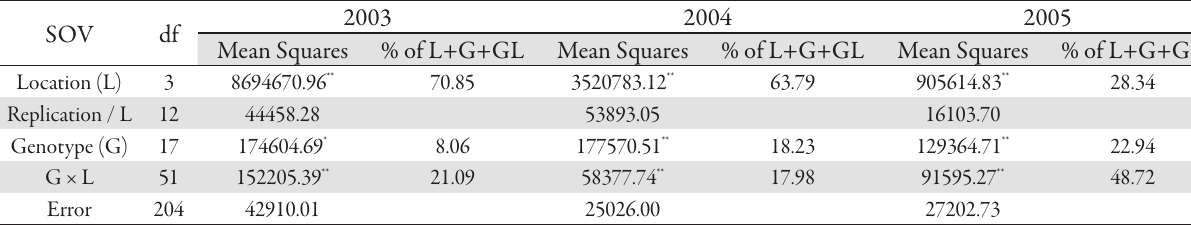
Fig. 2. GGE biplot of mean and stability of 18 lentil genotypes for yield and specific genotype × environment